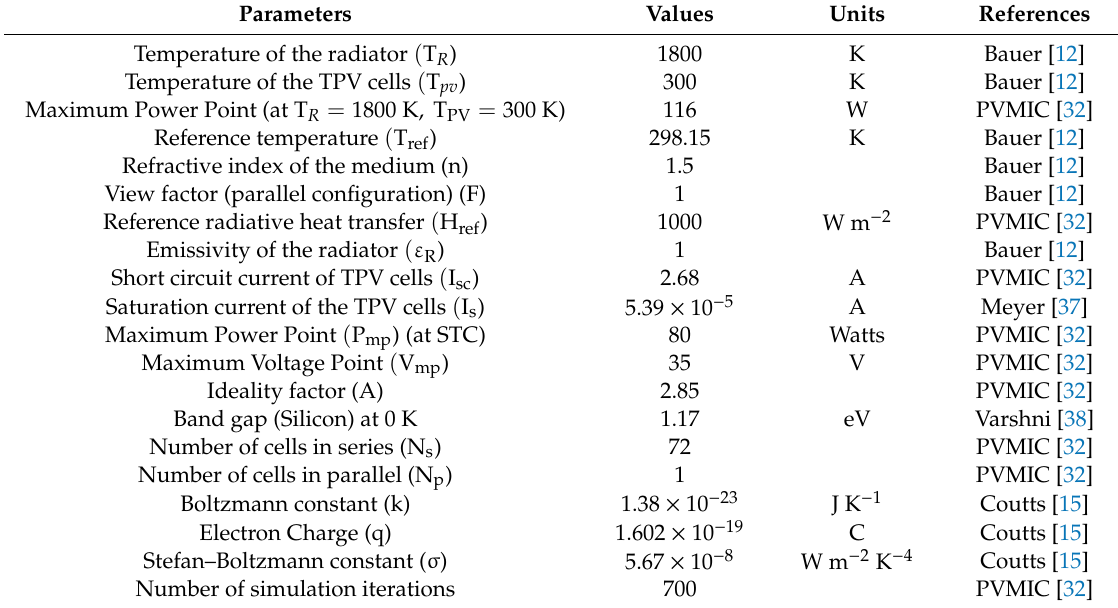
Table 1. Design and operational parameters of the thermophotovoltaic